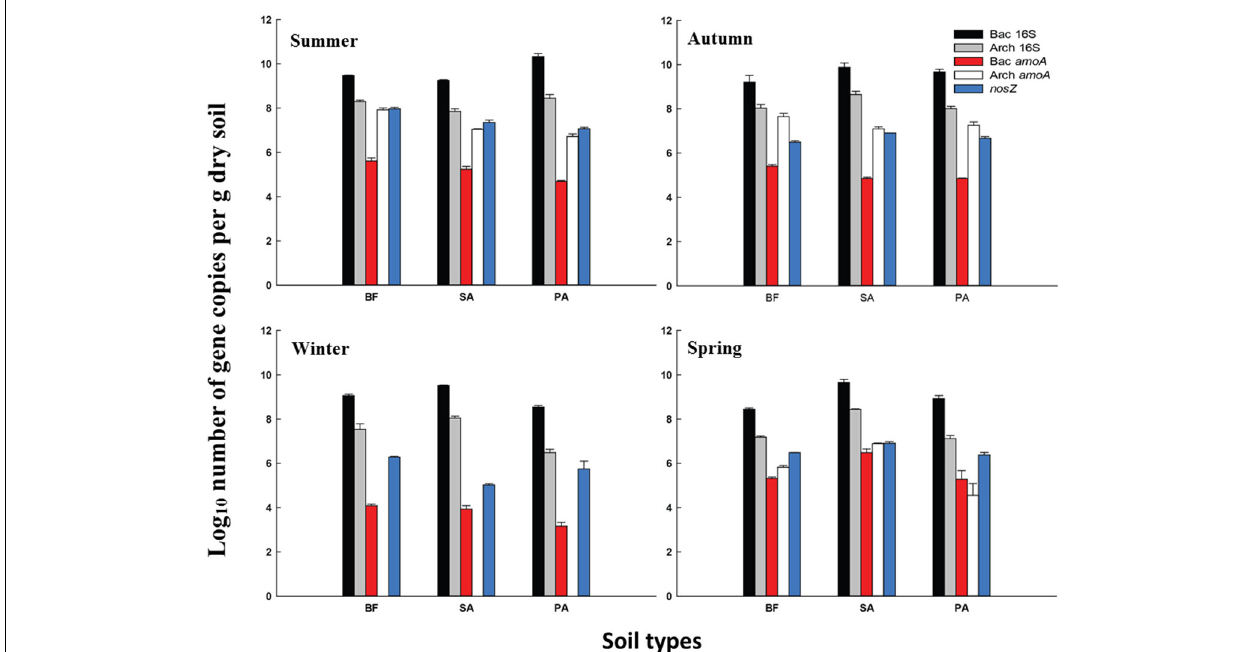
FIGURE 2 | Average gene copy numbers of 16S rRNA and the functional genes per g of three types of dry soil collected during the four season. Error bars represent the SD BF, soil at bare flat; SA, soil covered by Spartina